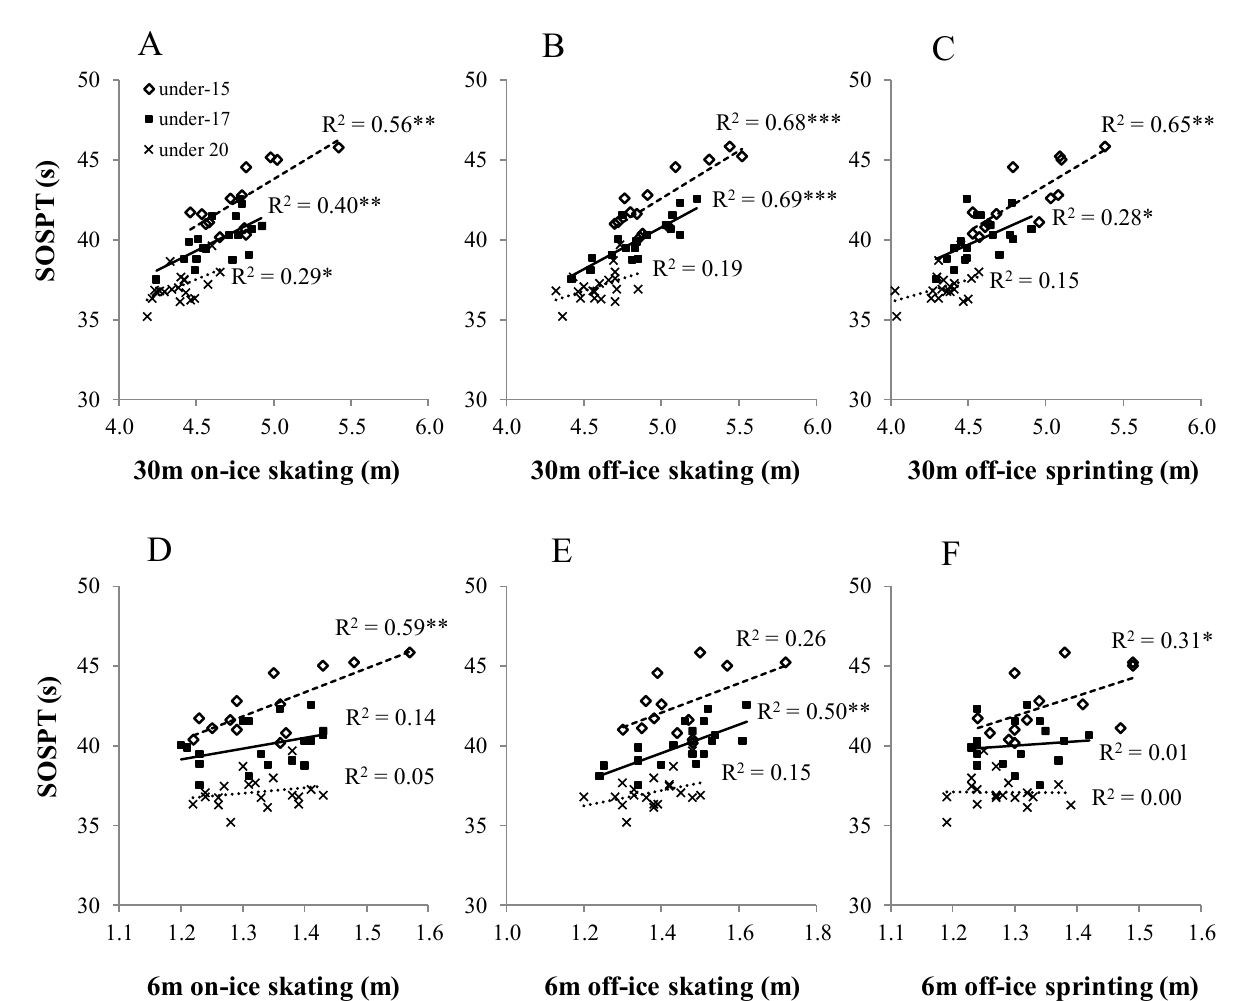
Figure 3. Linear regression analysis scatter-plot of the specific overall skating performance test (SOSPT) and ( A ) 30 m on-ice skating, ( B ) 30 m off-ice skating, ( C ) 30 m off-ice sprinting, ( D ) 6 m on-ice skating, ( E ) 6 m off-ice skating, and ( F ) 6 m off-ice sprinting time separated by age groups into under-20, under-17, and under-15 players. ( p < 0.001 ***; p < 0.01 **; p < 0.05 *).